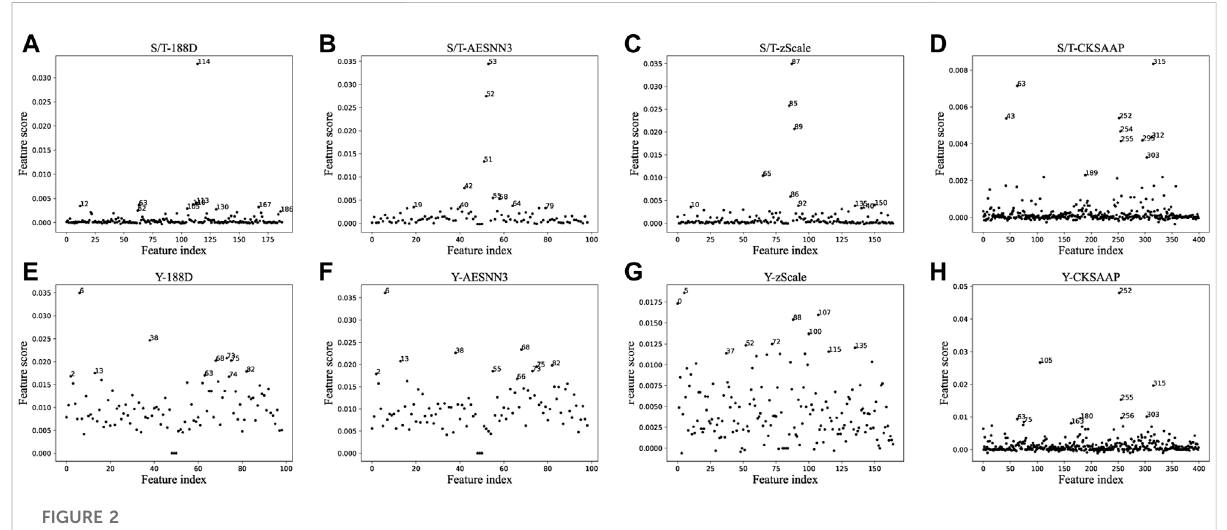
FIGURE 2 The scatter plots of feature importance using different feature extraction